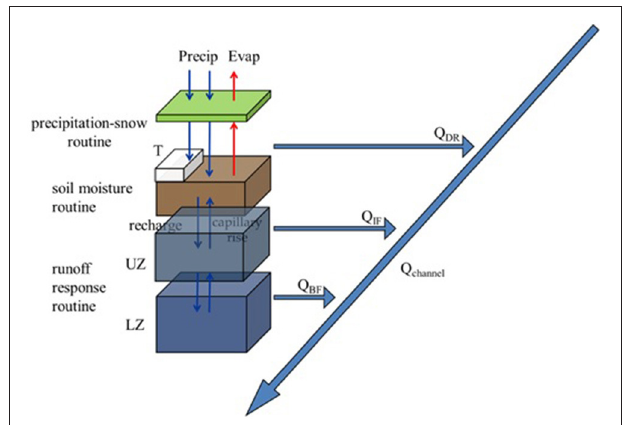
FIGURE 2 | OpenStreams wflow-hbv model